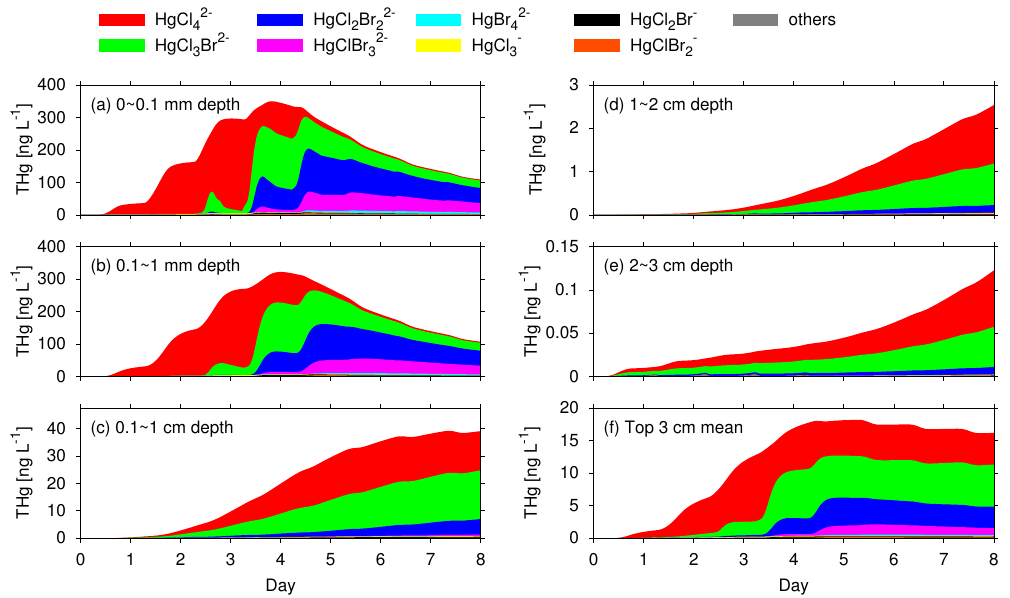
Fig. 13. Total concentrations and speciation of dissolved mercury in the top 3cm of snowpack as simulated with scenario 1A at U 2 = 4 . 5ms − 1 : (a) 0–0.1mm depth (the topmost snowpack layer), (b) 0.1–1mm depth, (c) 0.1–1cm depth, (d) 1–2cm depth, (e) 2–3cm depth, and (f) average over the top